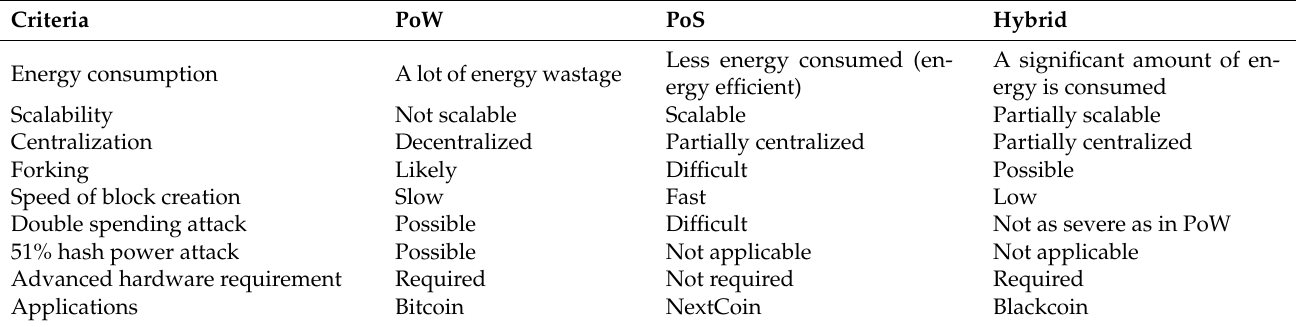
Table 5. A comparison between PoW and